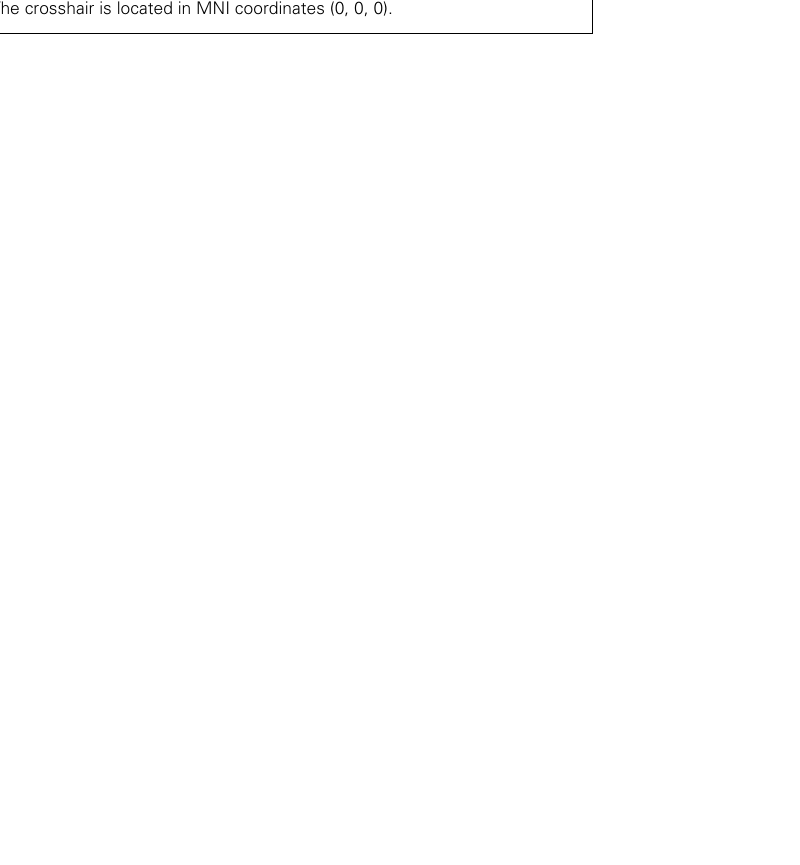
FIGUREA2 | Region-of-interest used for CCM analysis in experiment 2. The crosshair is located in MNI coordinates (0, 0,